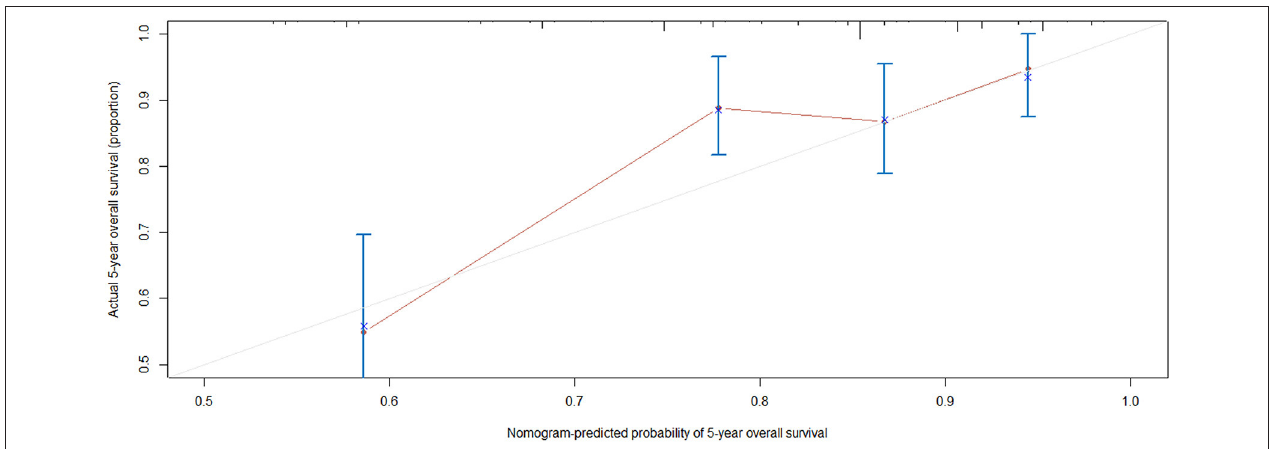
FIGURE 6 | Calibration curve. Nomogram-predicted probability of 5-years overall survival is plotted on the x-axis; actual 5-years overall survival is plotted on the y-axis. Shorter distance between two curves indicates higher